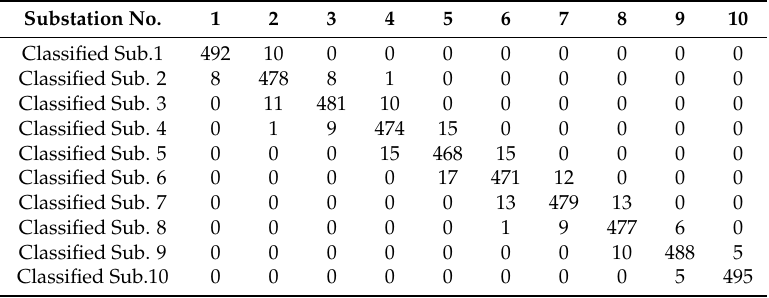
Table 3. Cases from subspaces test results.